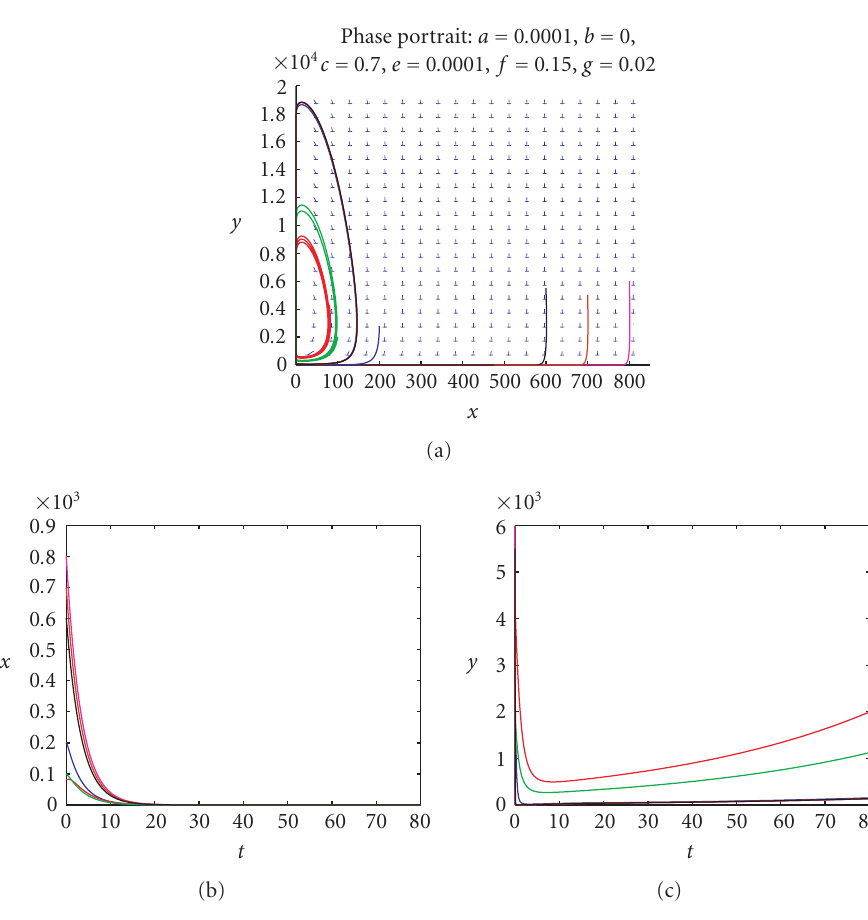
Figure 3.16. A comparison with Figures 3.13(a) and 3.14 showing that nonviolent intervention brings about lower steady state terrorist populations than those brought about by military/police interven- tion, when e (1 − c ) − ab > 0. The fixed point occurs at x 0 ≈ 14, y 0 = 3000.